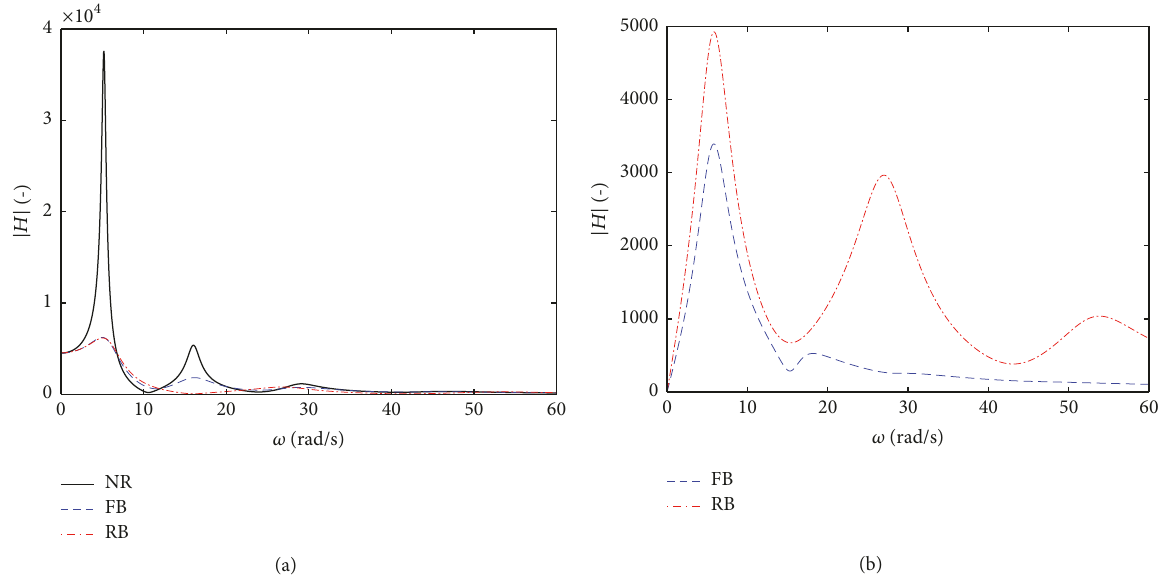
Figure 5: FRFs of the NR, FB, and RB systems in terms of (a) frame base shear; (b) external bracing base shear.